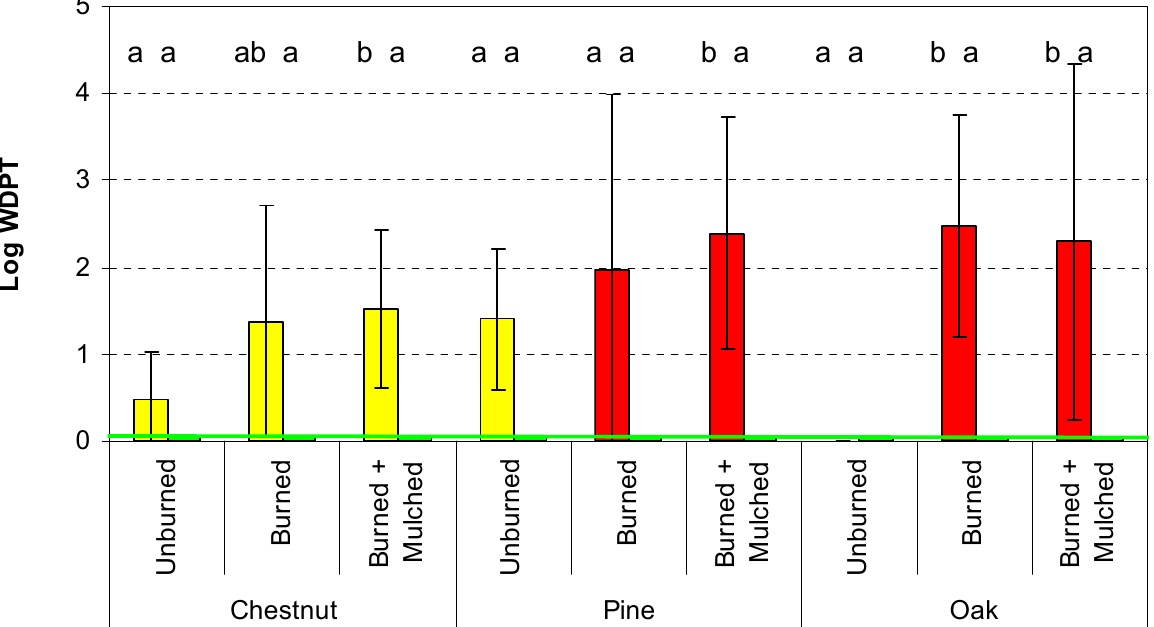
Figure 5. Soil water repellency (as WDPT) measured after prescribed fire and soil mulching with fern in the experimental site (Samo, Calabria, Southern Italy). Notes: Bars report mean ± std. dev. (n = 3); left and right bars of chart are the values measured one day and one year after the prescribed fire, respectively. Green, yellow and red colours refer to SWR class 0, 1 and 2, respectively. The green line identifies the non-repellency condition of soi. Different lowercase letters indicate significant differences in the interaction between soil conditions and time after fire, respectively, after Tukey’s test ( p < 0.05).